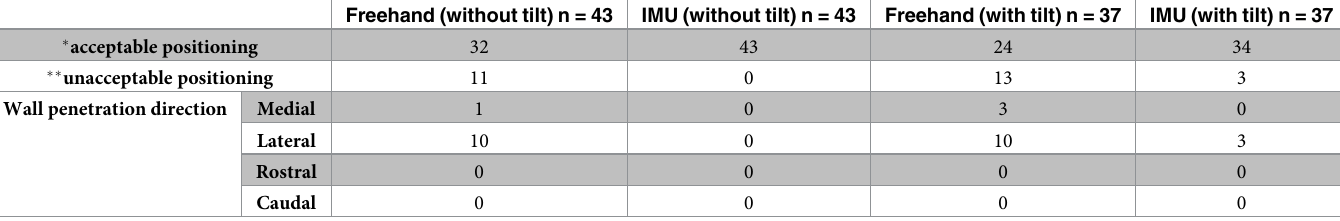
Table 4. Screw positioning and direction of unacceptable wall penetration in the freehand and IMU-assisted groups according to the Gertzbein and Robbins classi- fication